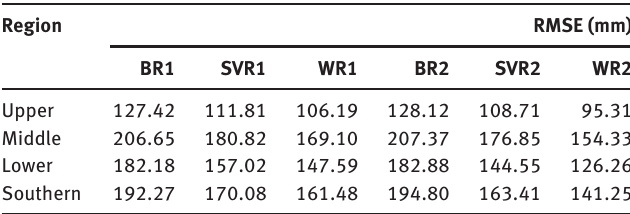
Table 4: RMSEs Obtained for Different Parts of Assam Using Six Models.